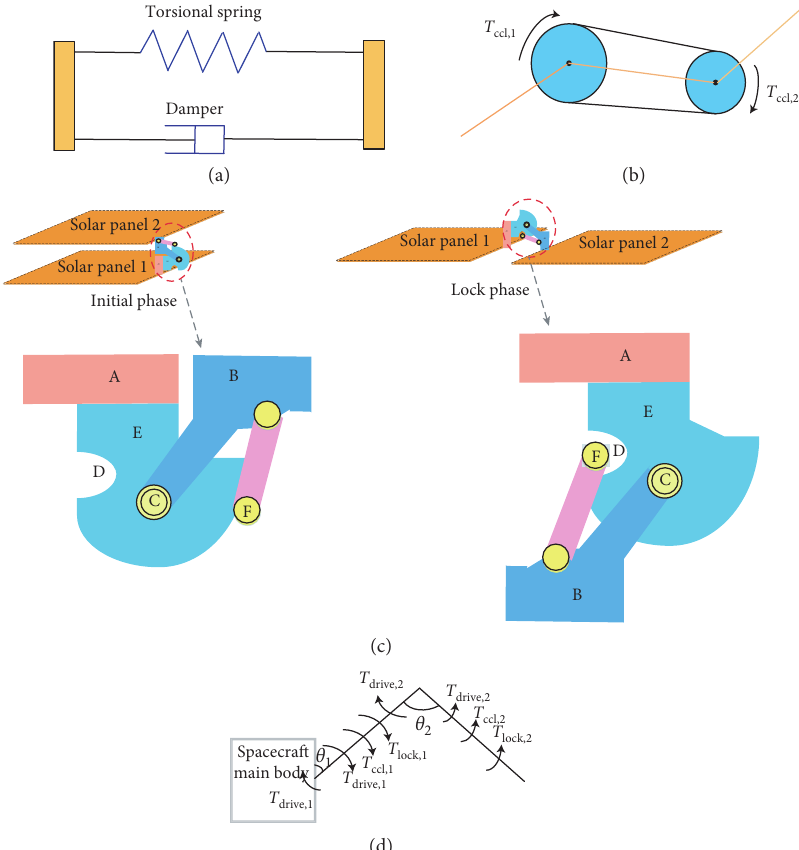
Figure 2: Representations of the solar array’s mechanisms and torque models. (a) Spring-damper mechanism. (b) CCL mechanism. (c) Latch mechanism. (d) Torque model of the solar